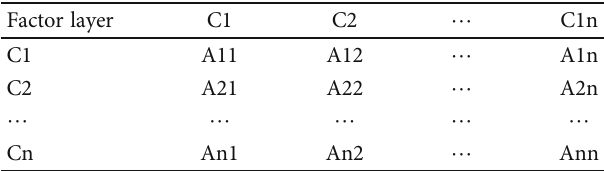
Table 1: The judgment matrix.